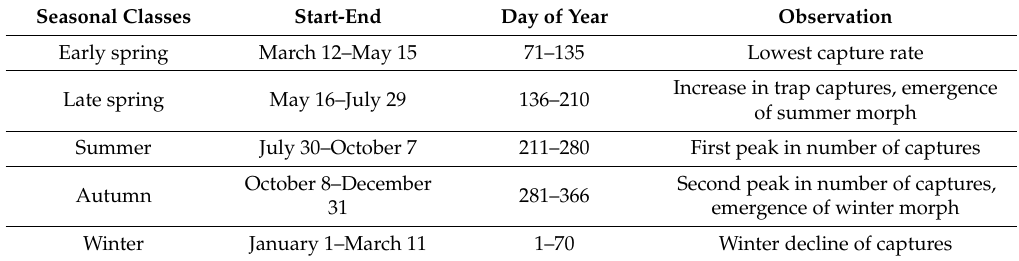
Table 2. Definitions of the five phenology classes representing the activity patterns of adult D. suzukii